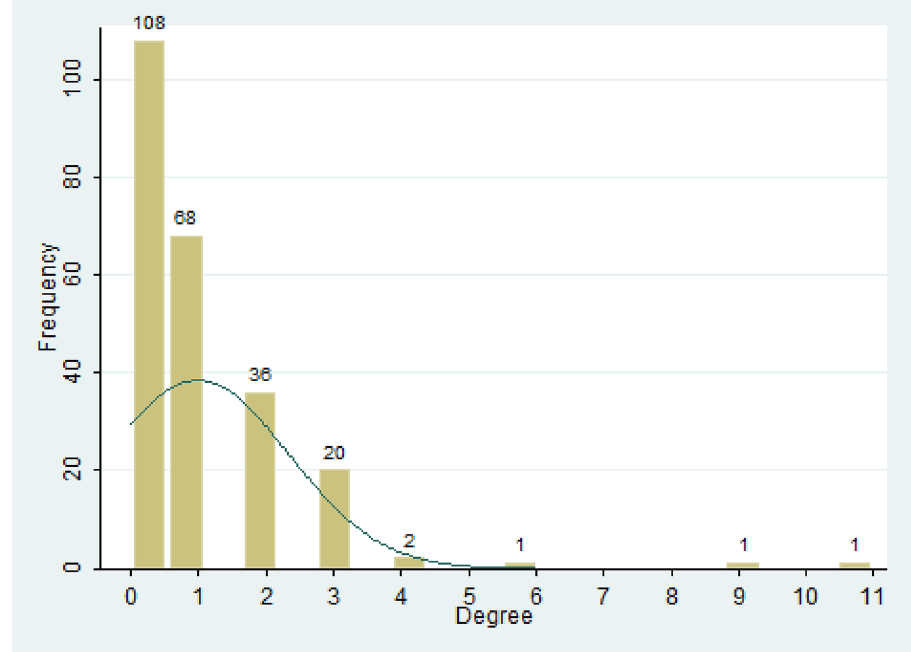
Figure 6. Distribution of degree centrality of contact network of COVID-19 cases in Shaanxi